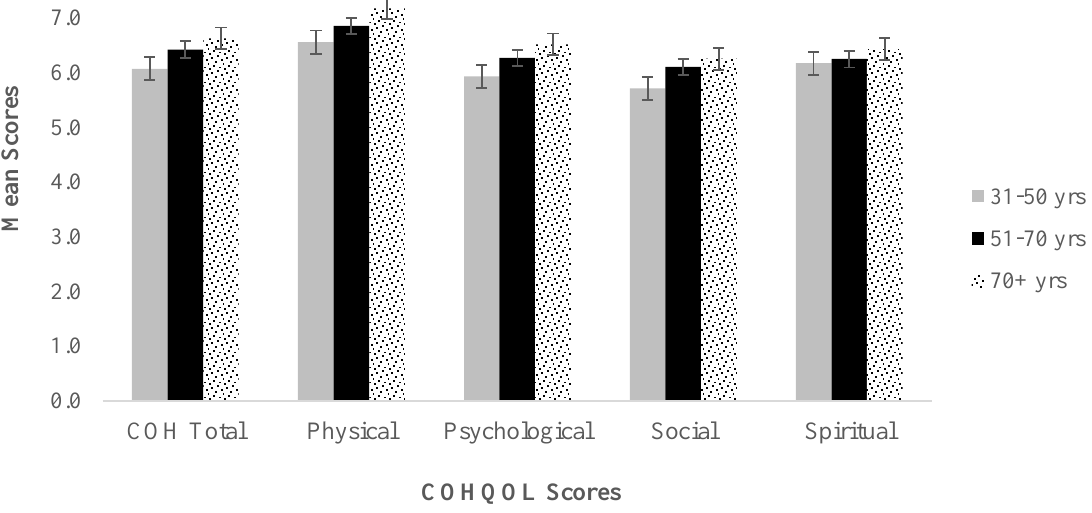
Figure 1. Average scores for total COH and subscales according to age groups.